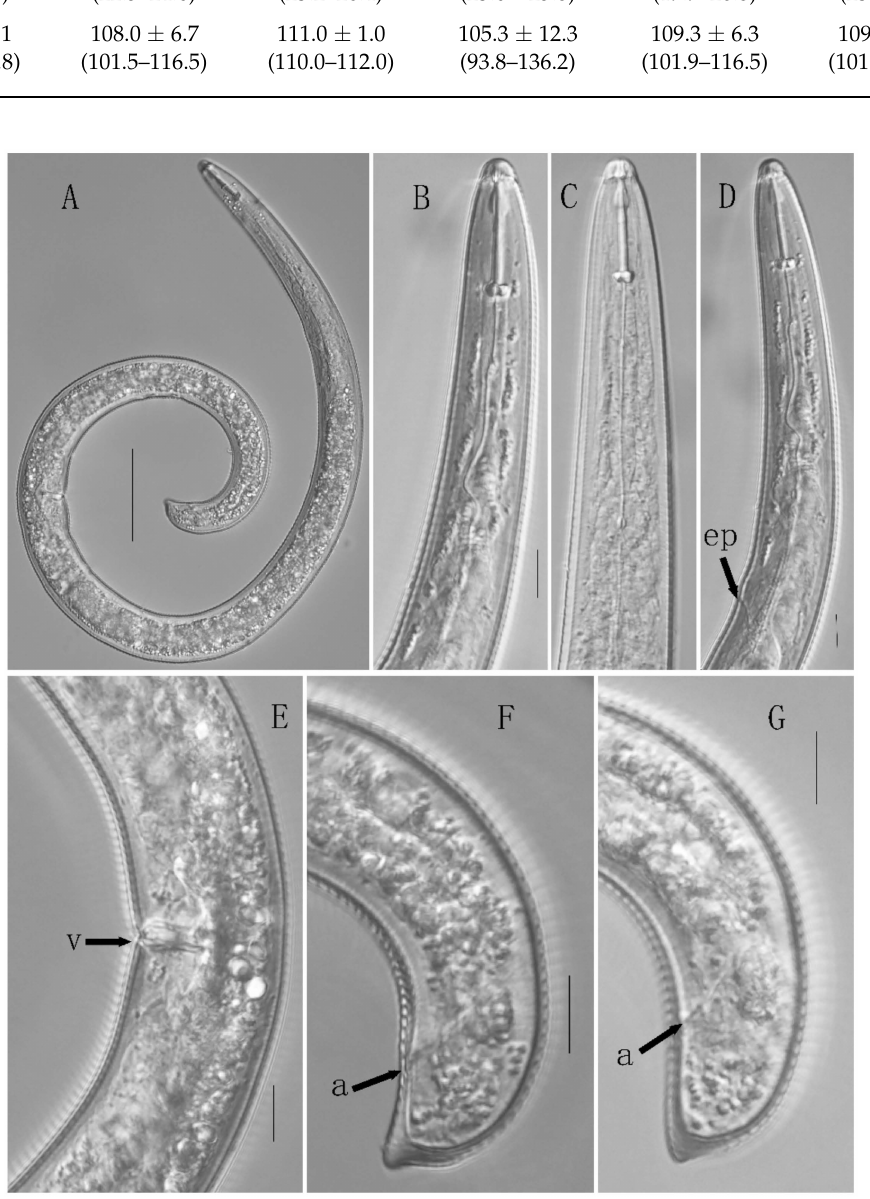
Figure 1. Adult female of Helicotylenchus dihystera in lateral view. ( A ): Entire body; ( B , C ): Anterior body; ( D ): Anterior body (ep arrow refers to excretory pore); ( E ): Vulva (v arrow); ( F , G ): Tails (a arrow refers to anus). (Scale bars: ( A ) = 50 µ m; ( B – G ) = 10 µ